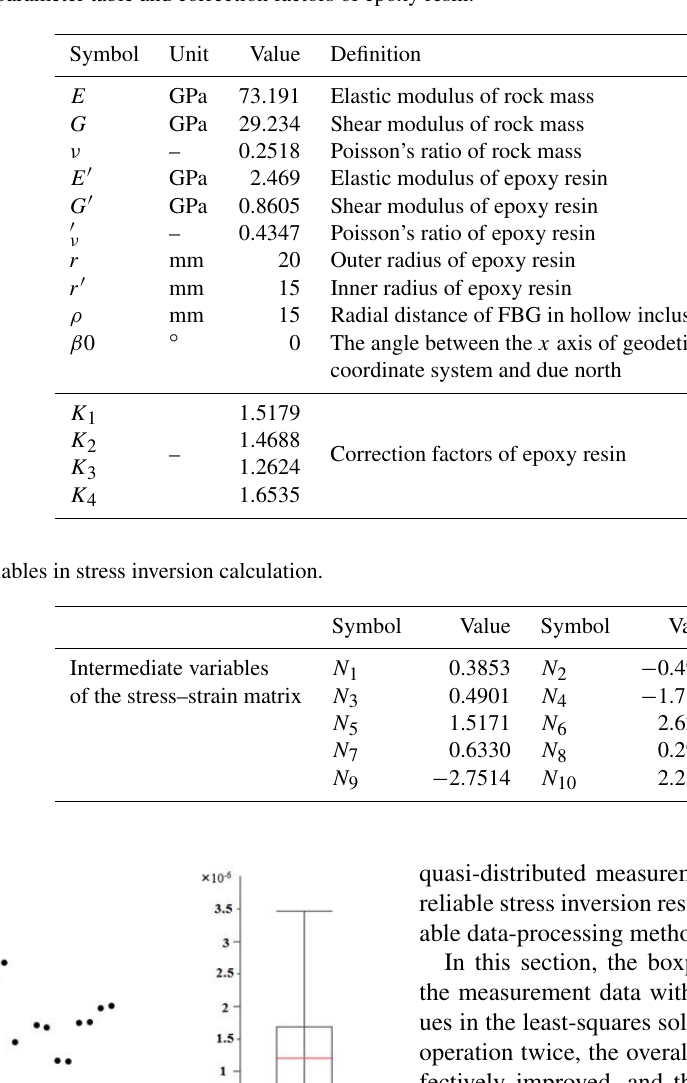
Table 8. Stress inversion parameter table and correction factors of epoxy resin.